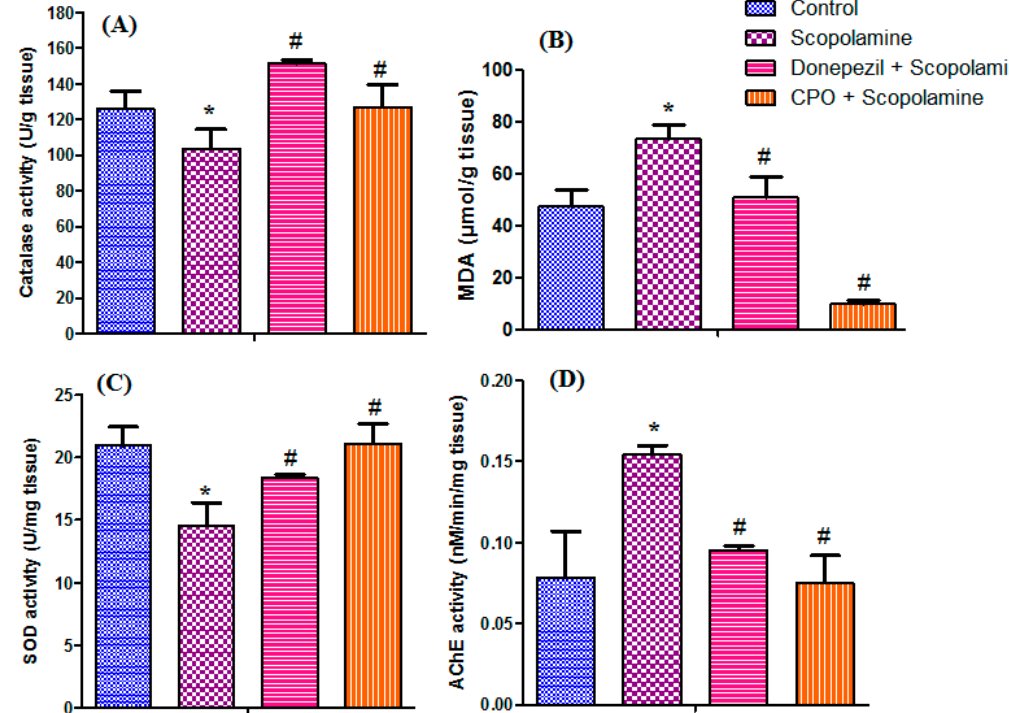
Figure 2. Effect of cold-pressed pepper oil on levels of catalase ( A ), MDA ( B ), SOD ( C ), and AChE ( D ). Data are expressed as mean ± SEM, n = 6. *, significant difference ( p < 0.05) from the control group, #, significant difference ( p < 0.05) from the SC-treated group. This figure was adopted from Mostafa [10].